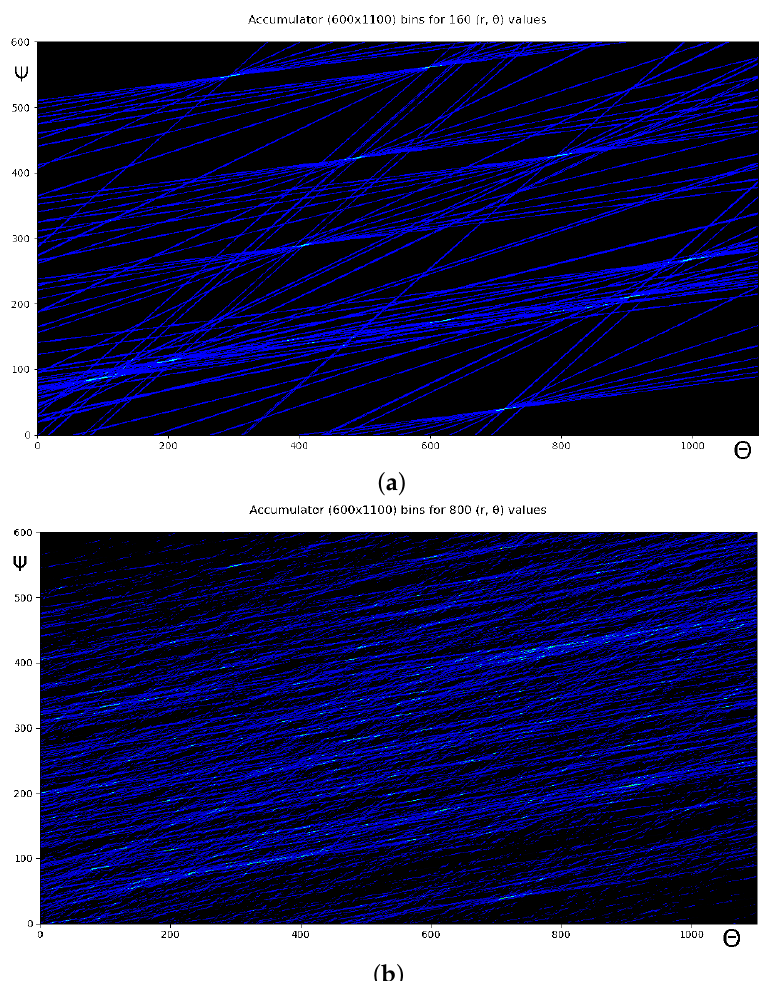
Figure 3. The 1100 × 600 bins 2D plots of the PS after executing the HT Formula (2): ( a ) 10 HT-points without noise; ( b ) 10 HT-points with 640/800 = 80% of noise